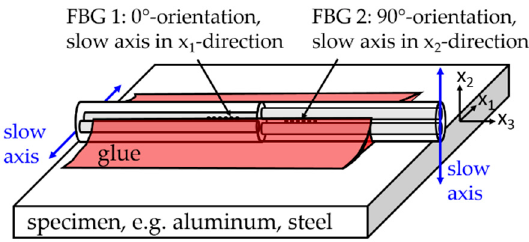
Figure 1. A surface-attached polarization-maintaining fiber Bragg grating (PM-FBG) tandem sensor element for strain-decoupled temperature measurements: The sensor tandem consists of a splice of a Panda fiber with its slow axis aligned perpendicular to the slow axis of the second fiber. Two FBGs were inscribed at either side of the splicing joint. The sensor tandem is azimuthally aligned with the slow and fast axis parallel and perpendicular to the surface and glued along the whole length of the sensor element to the specimen.